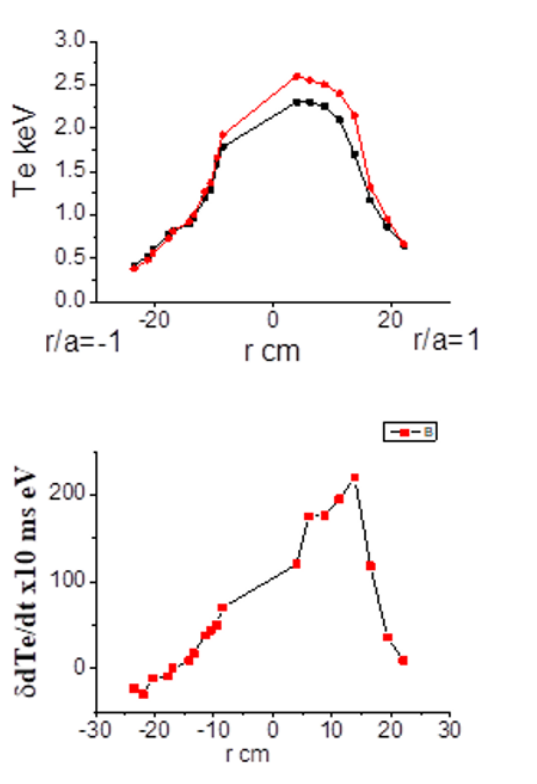
Fig.7. (a) Profiles of Te before and 20 ms after L-H transition (b) The radial profile of δ(  Te/  t) x 10ms at the L-H